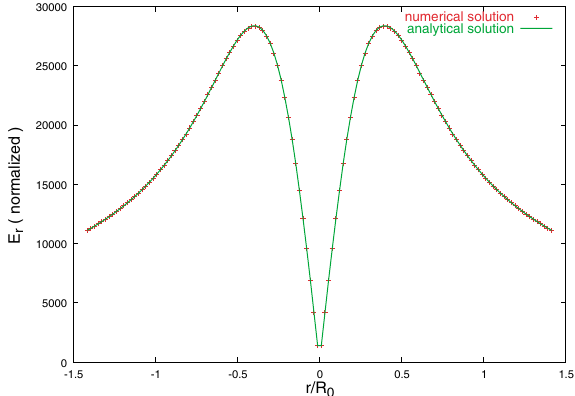
FIG. 2. (Color) Radial electric field as a function of distance along the diagonal line of the particle domain.